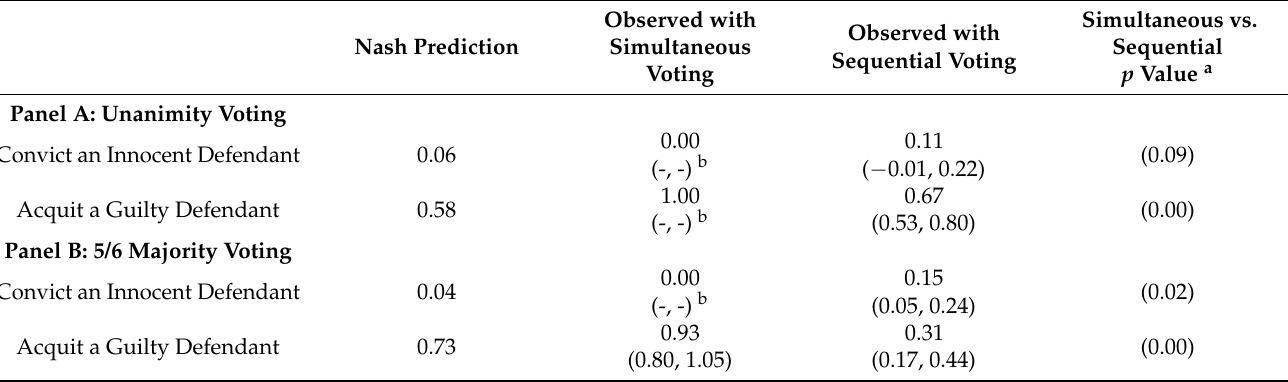
Table 7. Comparison of observed jury voting outcomes (95% confidence level) and mixed strategy nash equilibrium with risk